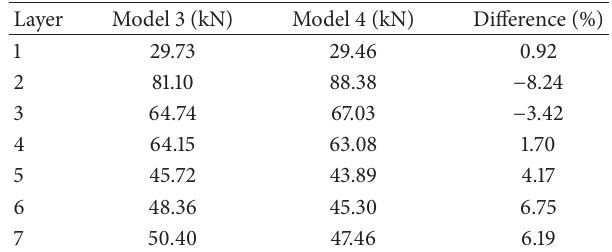
the transmission tower could be underestimated by more than 30% and 45%, respectively.